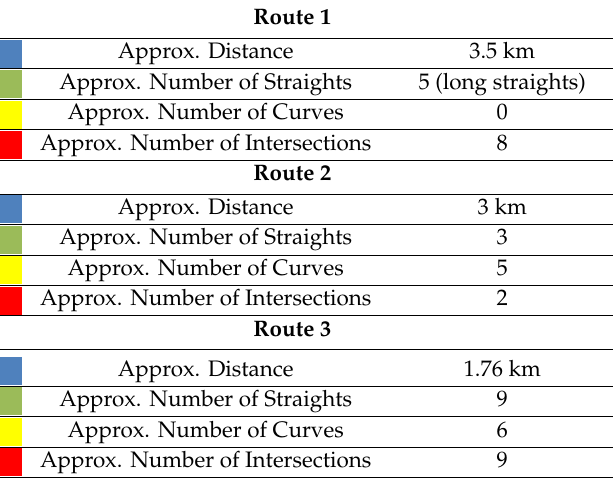
Table 2. Road details: Route 1, Route 2 and Route 3.